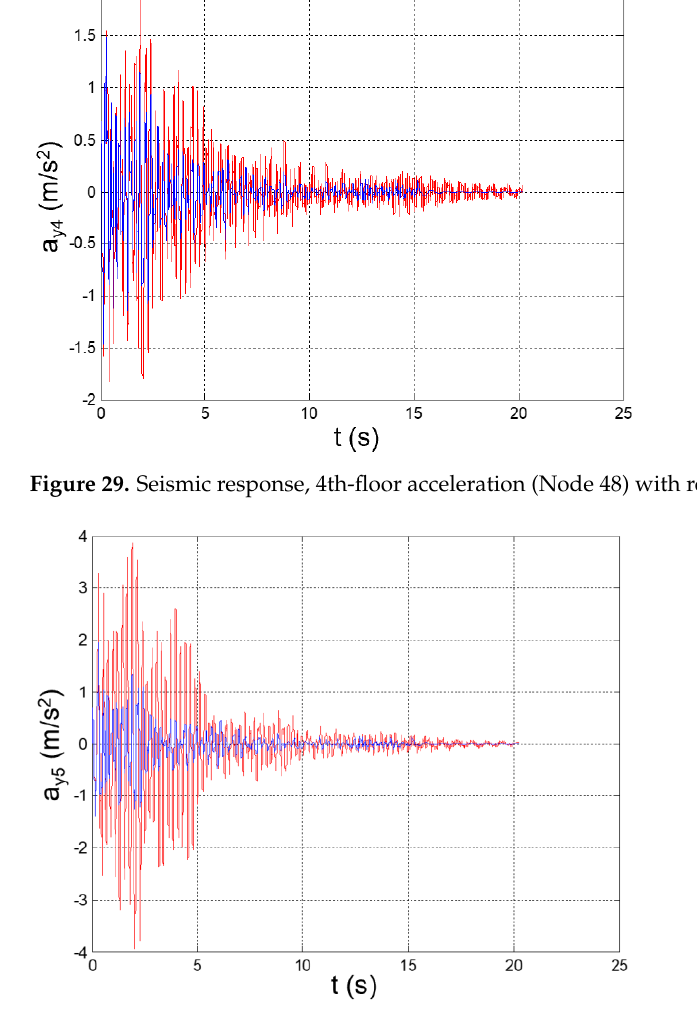
Figure 30. Seismic response, 5th-floor acceleration (Node 49) with respect to the ground.